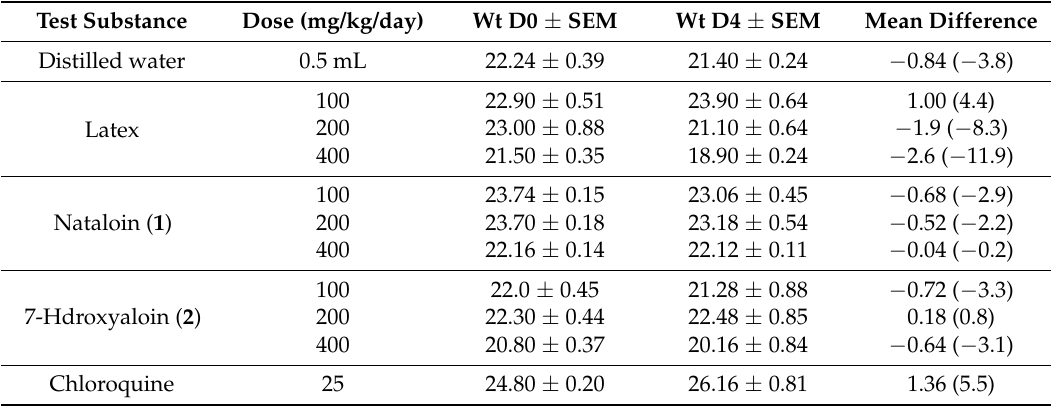
Table 2. Body weight of Plasmodium berghei -infected mice after the administration of leaf latex